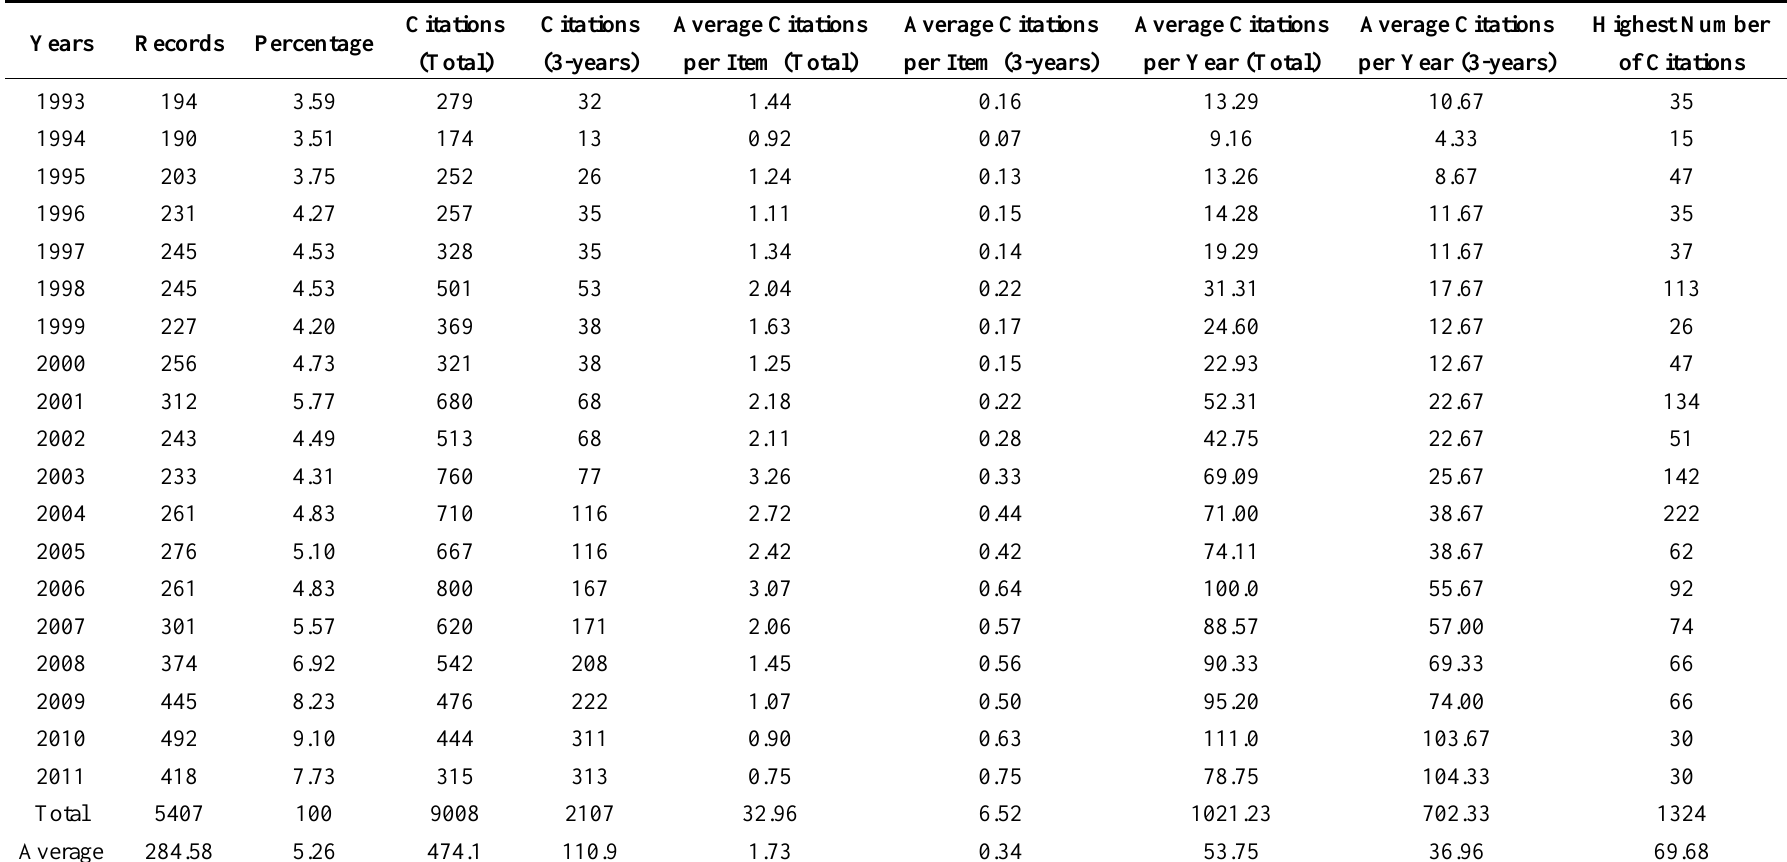
Table 1. Growth of research productivity and citation analysis of the 5407 indexed scholarly communications published in the field of Buddhism and Buddhist studies from 1993 to